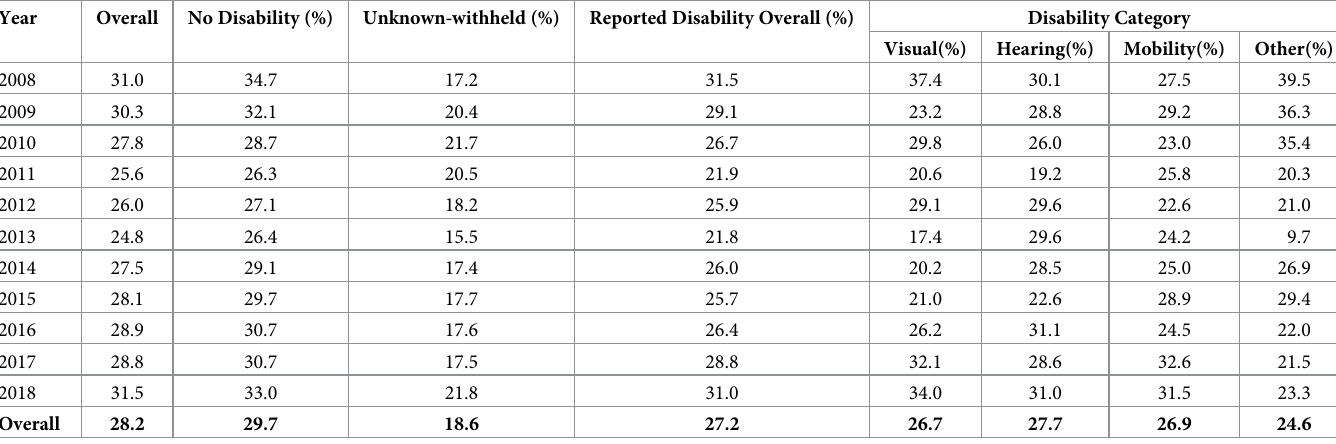
Table 2. Grant success rate � among National Institute of Health Grants by year and Principal Investigator Disability Status: 2008 to 2018. Year Overall